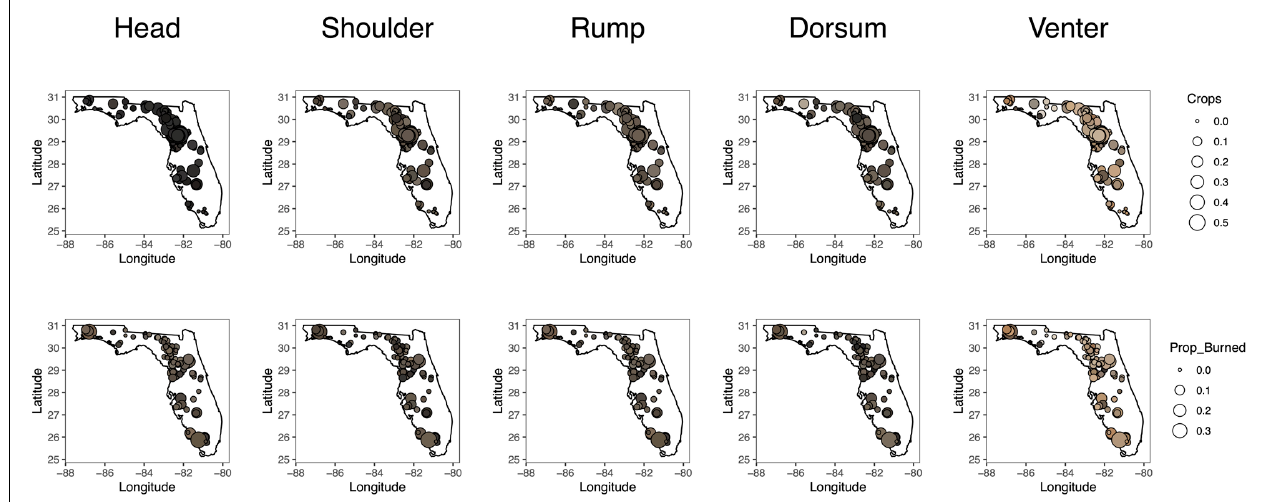
FIGURE 2 | Maps showing the locations of 135 roadkill fox squirrels collected throughout Florida used to investigate the role of environmental drivers of polymorphism. The fill color of each circle corresponds with the color measured at each location on an individual squirrel. The size of the circle corresponds with the proportion of cropland (top) and burned area (bottom) within a fox squirrel dispersal